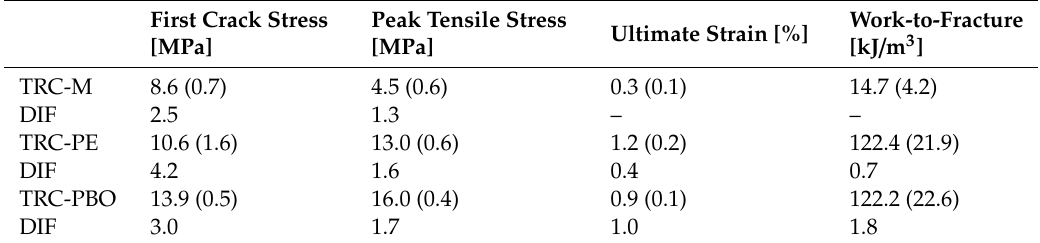
Figure 10. ( a – c ) Tensile stress–strain curves of the composites under impact loading (the global strain rate curves are represented by dashed lines) and ( d ) representative stress–strain relationships for the composites under investigation. Table 7. Results of the uniaxial impact tension tests on the composites under investigation (average values; standard deviations are given in parentheses).